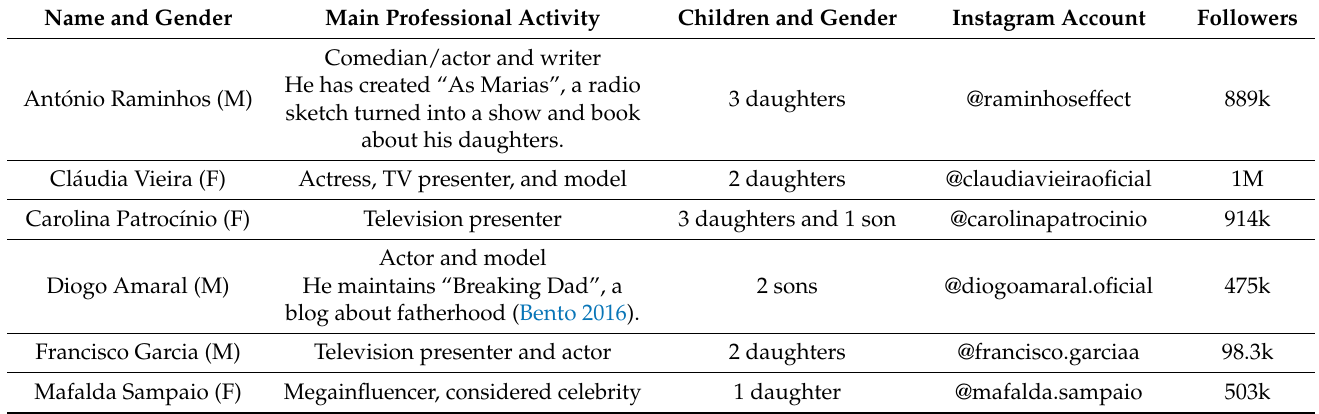
Table 1. Celebrities’